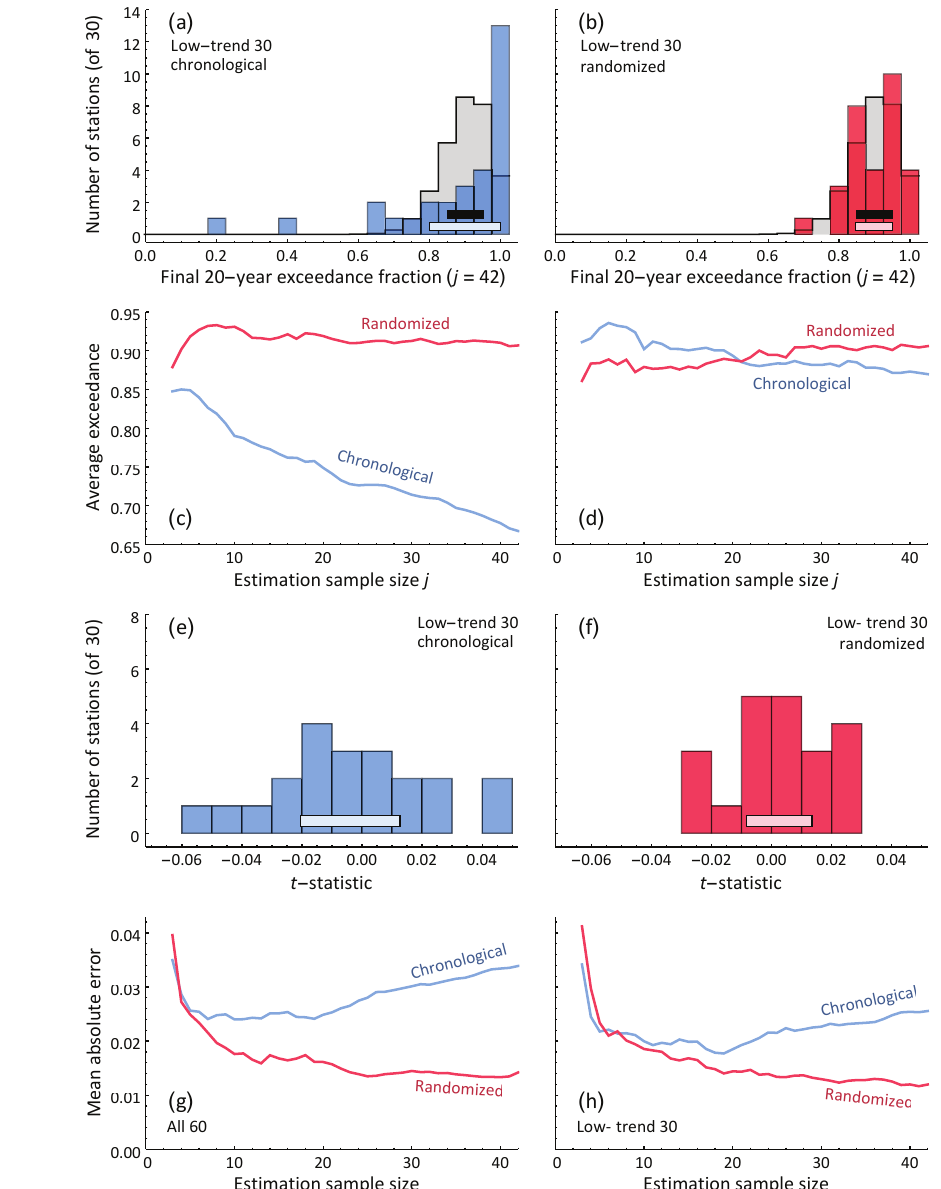
Figure 10. (a) , (b) Distribution of fractions of each of the 30 low-trend station’s final 20 years with c.f. exceeding estimated P90 ( j = 42) for actual and randomized data with binomial PDF (gray) and central two quartiles (binomial: black bar; data: light bars). (c) , (d) P90 bias for all 60 stations, and for the 30 stations with low average trend. (e) , (f) Distribution of difference between c q 10 and the data set’s 10% quantile for actual and randomized data, respectively, of 30 low-average-trend stations (light horizontal bars: central two quartiles). (g) , (h) P90 estimate MAE for all 60 stations and for 30 stations with low average